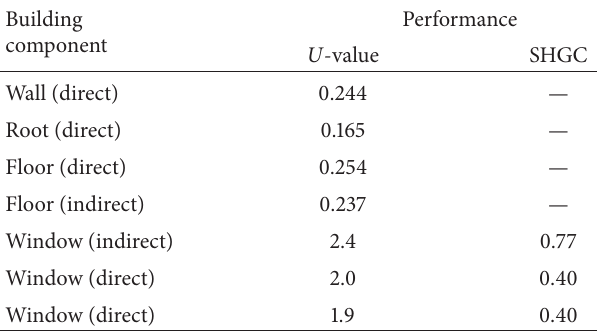
Table 6: Envelope performance of target building.